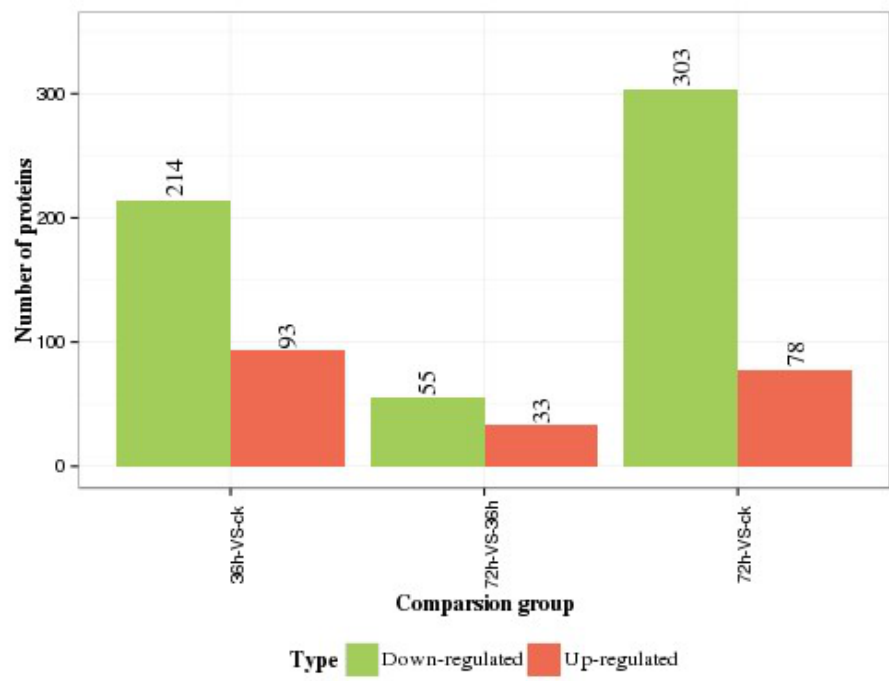
Figure 3. Cluster of orthologous group (COG) classification of the identified proteins in hemocytes.